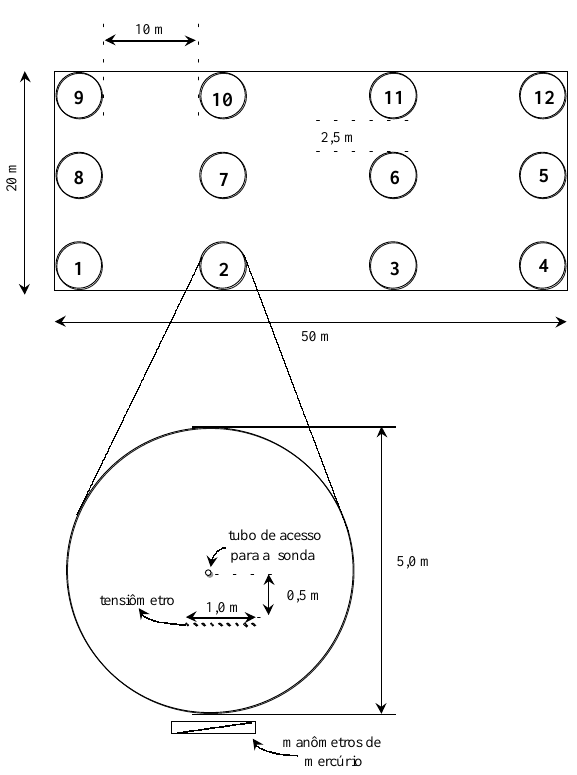
Figura 1. Esquema da área experimental mostrando a localização relativa dos doze locais de observação e, em detalhe, a configuração de um local de